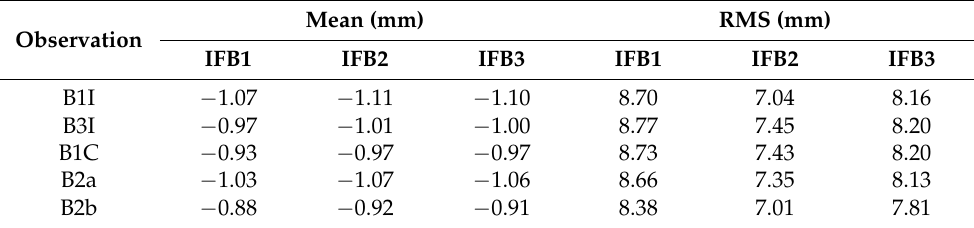
Table 4. The means and RMS of the phase residuals among different IFCB handling